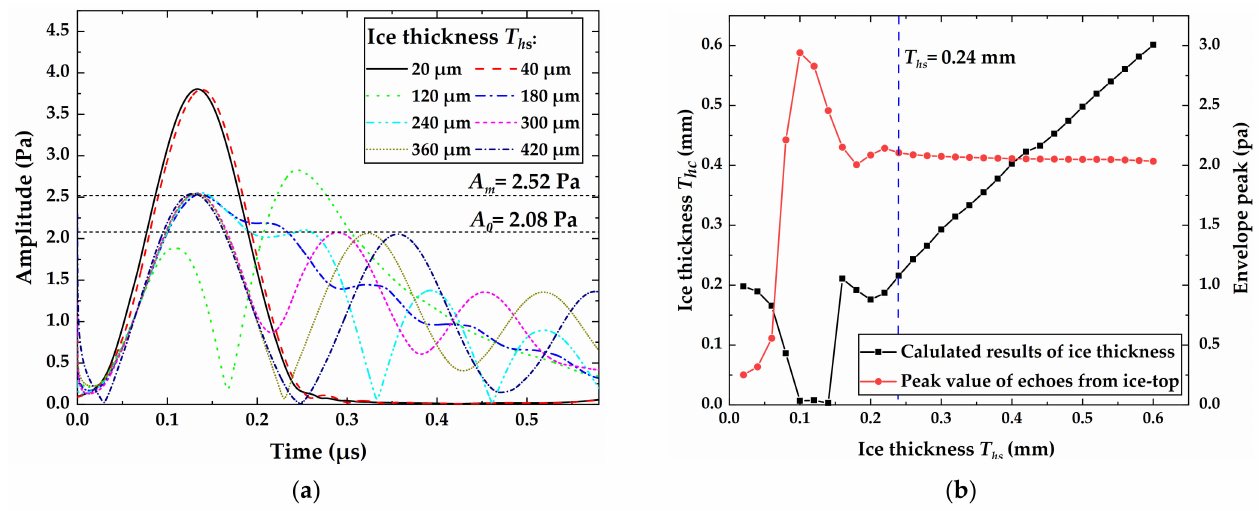
Figure 10. Simulation results for echo envelopes from a smooth ice top: ( a ) echo envelopes for different ice thicknesses; ( b ) ice thickness and envelope